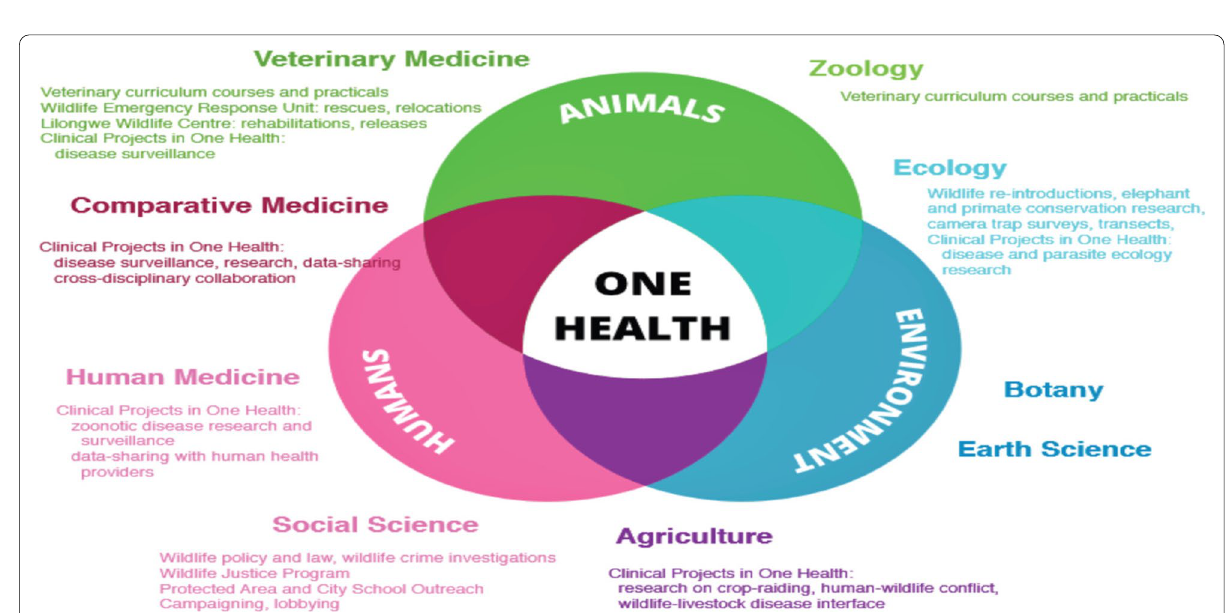
Fig. 2 Typical example of one health coordination, Lilongwe Wildlife Trust, Clinical Project in One Health, Malawi